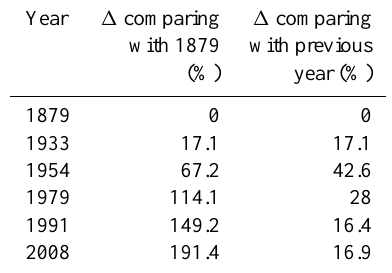
Table 5. Percent increase of the area occupied by the city, compared with the first known situation (second column) and with the previ- ous analysis (third column). Value started from the total column in Table 3 and calculated as: (1.50-1.28)/1.28 × 100